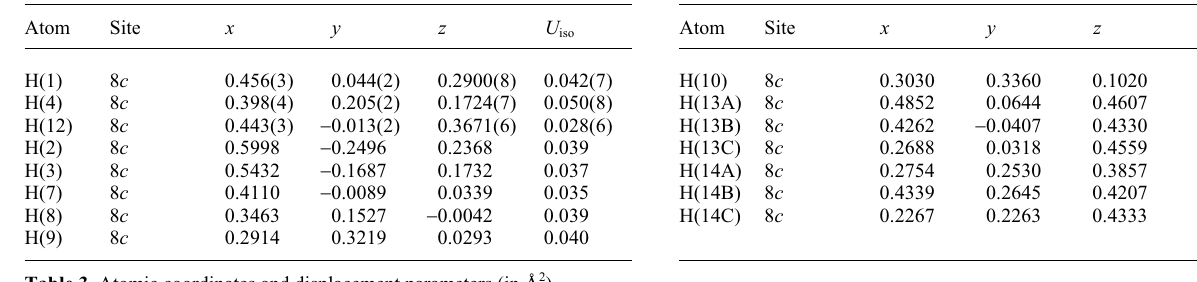
Table 2. Atomic coordinates and displacement parameters (in Å 2 ) .